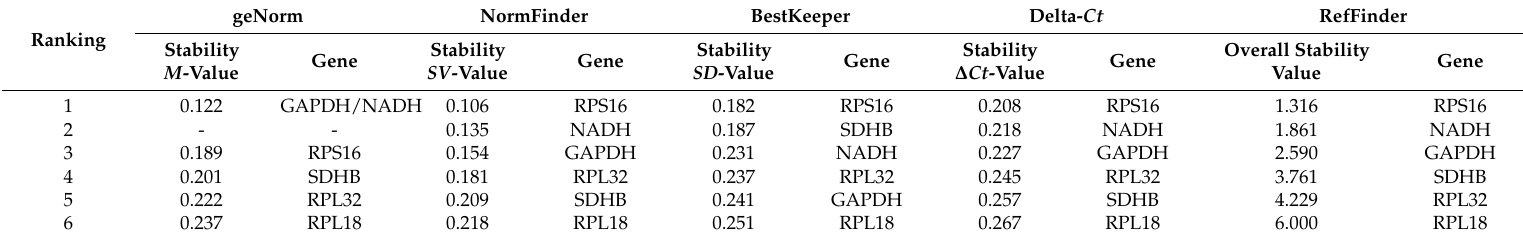
Table 4. Ranking of candidate reference genes according to stability values evaluated in castes of A. sexdens.